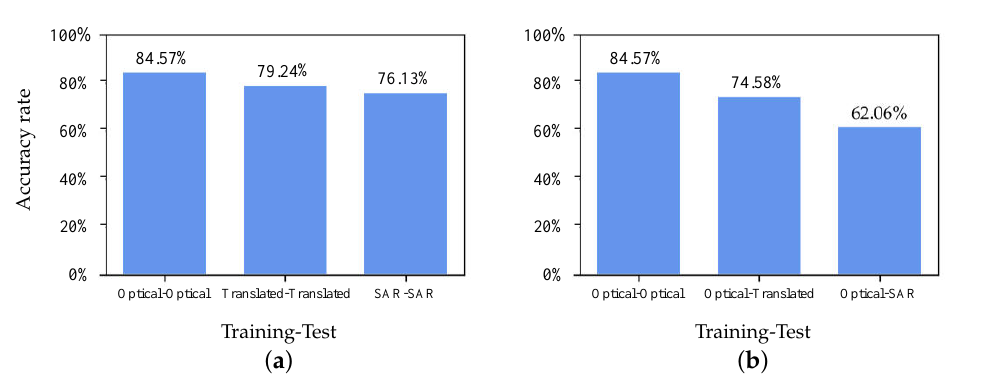
Figure 6. Results of recognition. The ordinates indicate the recognition accuracy. In the horizontal coordinate, the former is the type of training data, and the latter is the type of test data. ( a ) represents the results of training and testing using the same kind of data. ( b ) represents the results of training with optical images, testing with optical images, translated images, and SAR images.